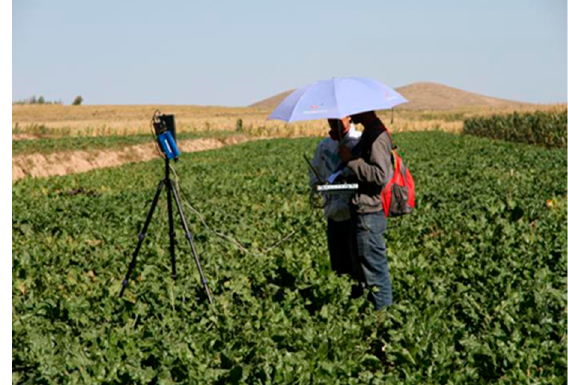
Figure 2. The canopy reflectance spectral measurements in the field.